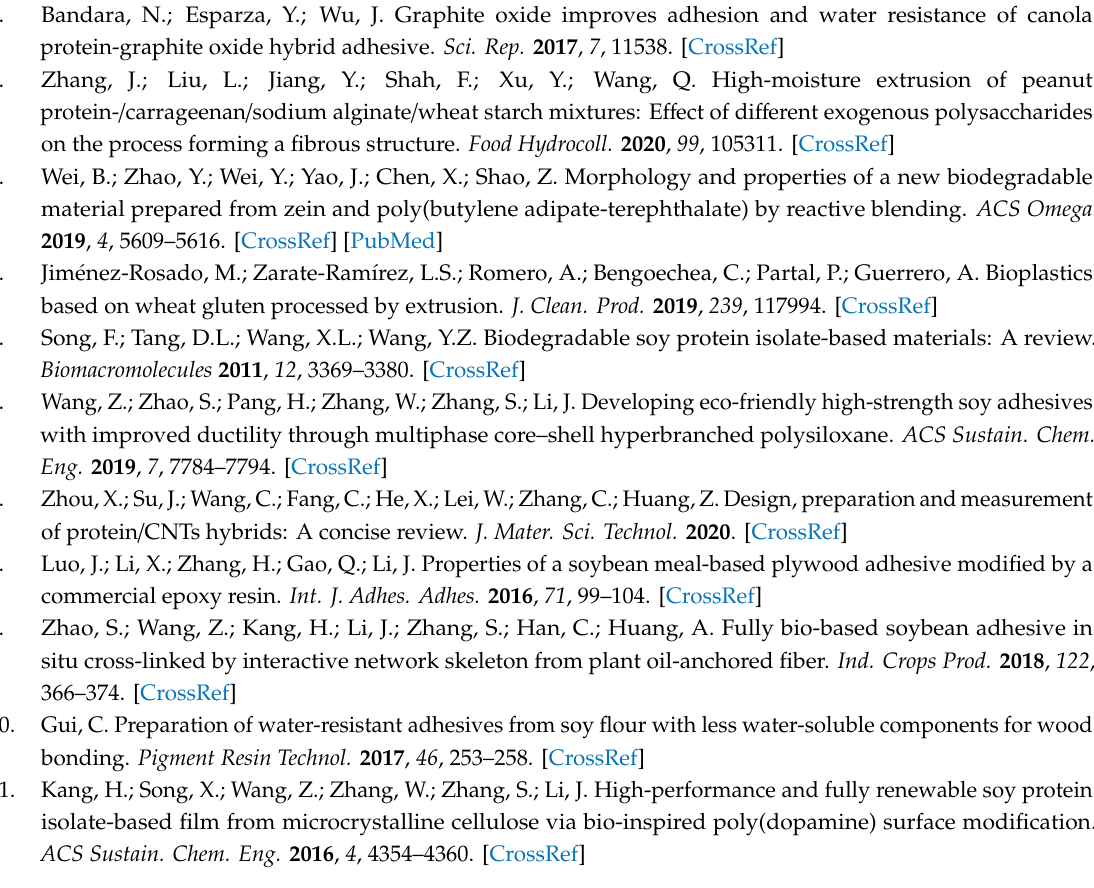
Figure S1: DSC curves of pristine soybean meal (SM) and blood meal (BM). Figure S2: The wet shear strength of plywood bonded by modified SM / BM-based adhesives. Figure S3: Mildewproof activities of the control adhesives under di ff erent mildew treatment